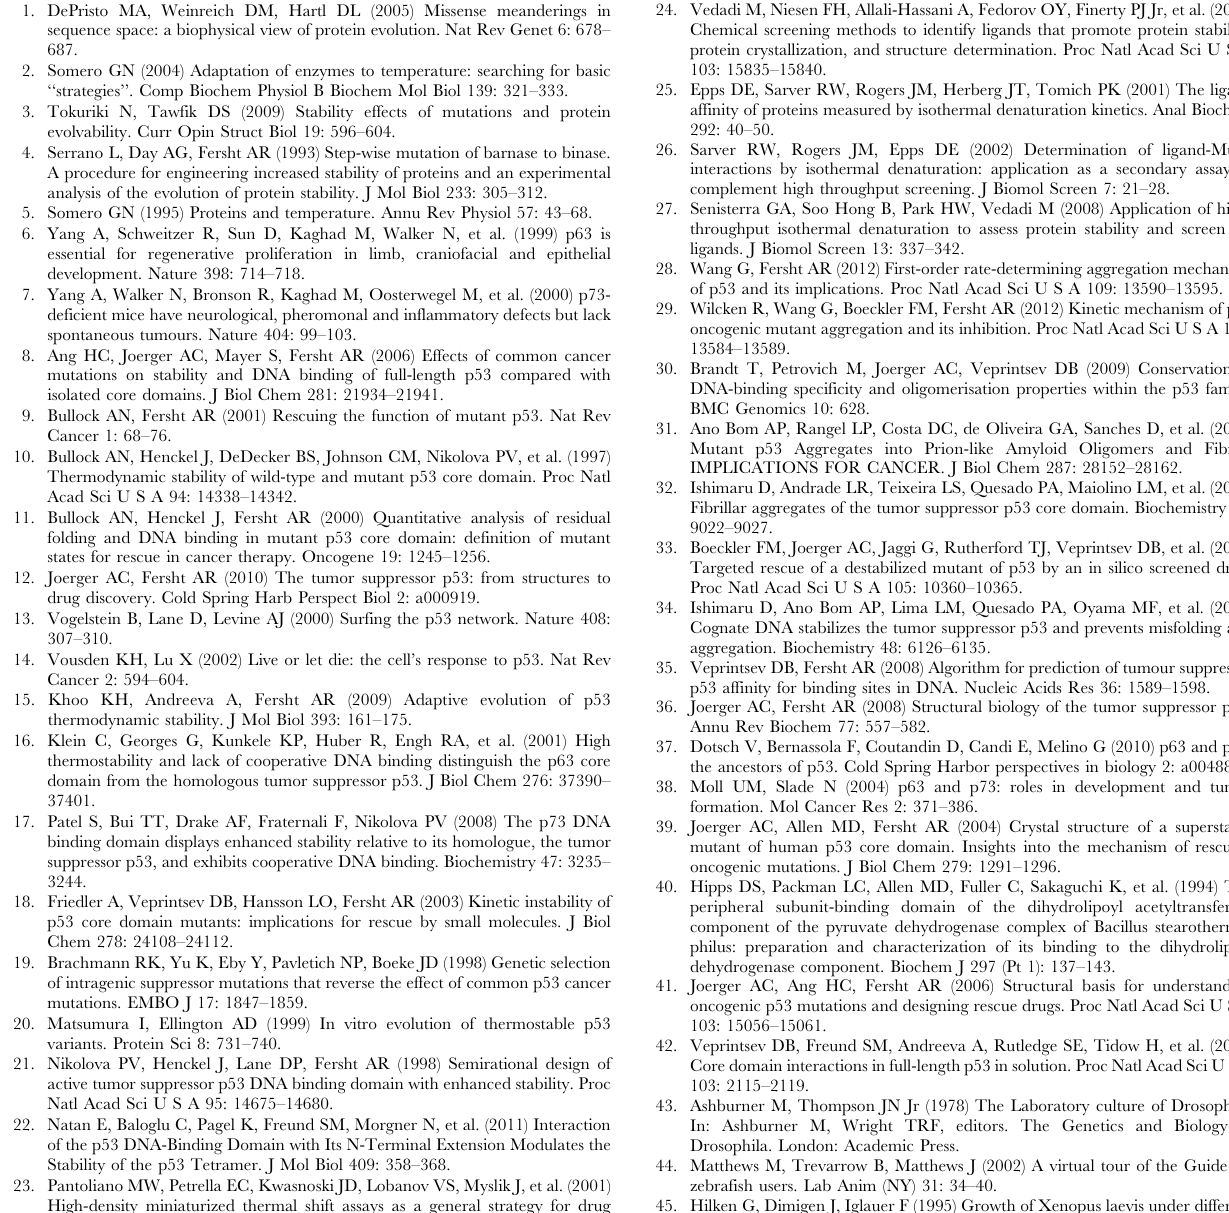
Figure S2 Kinetic denaturation of